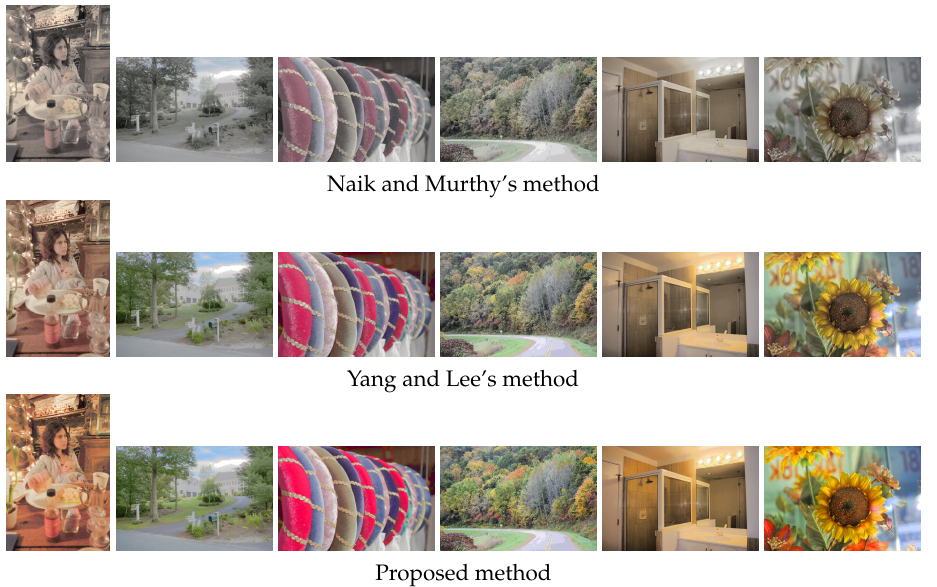
Figure 14. Histogram specification applied to color images in Figure 12, where the top, middle and bottom rows show the output images by Naik and Murthy’s, Yang and Lee’s and the proposed bottom rows show the output images by Naik and Murthy’s method, Yang and Lee’s method and methods, respectively. the proposed method, respectively.